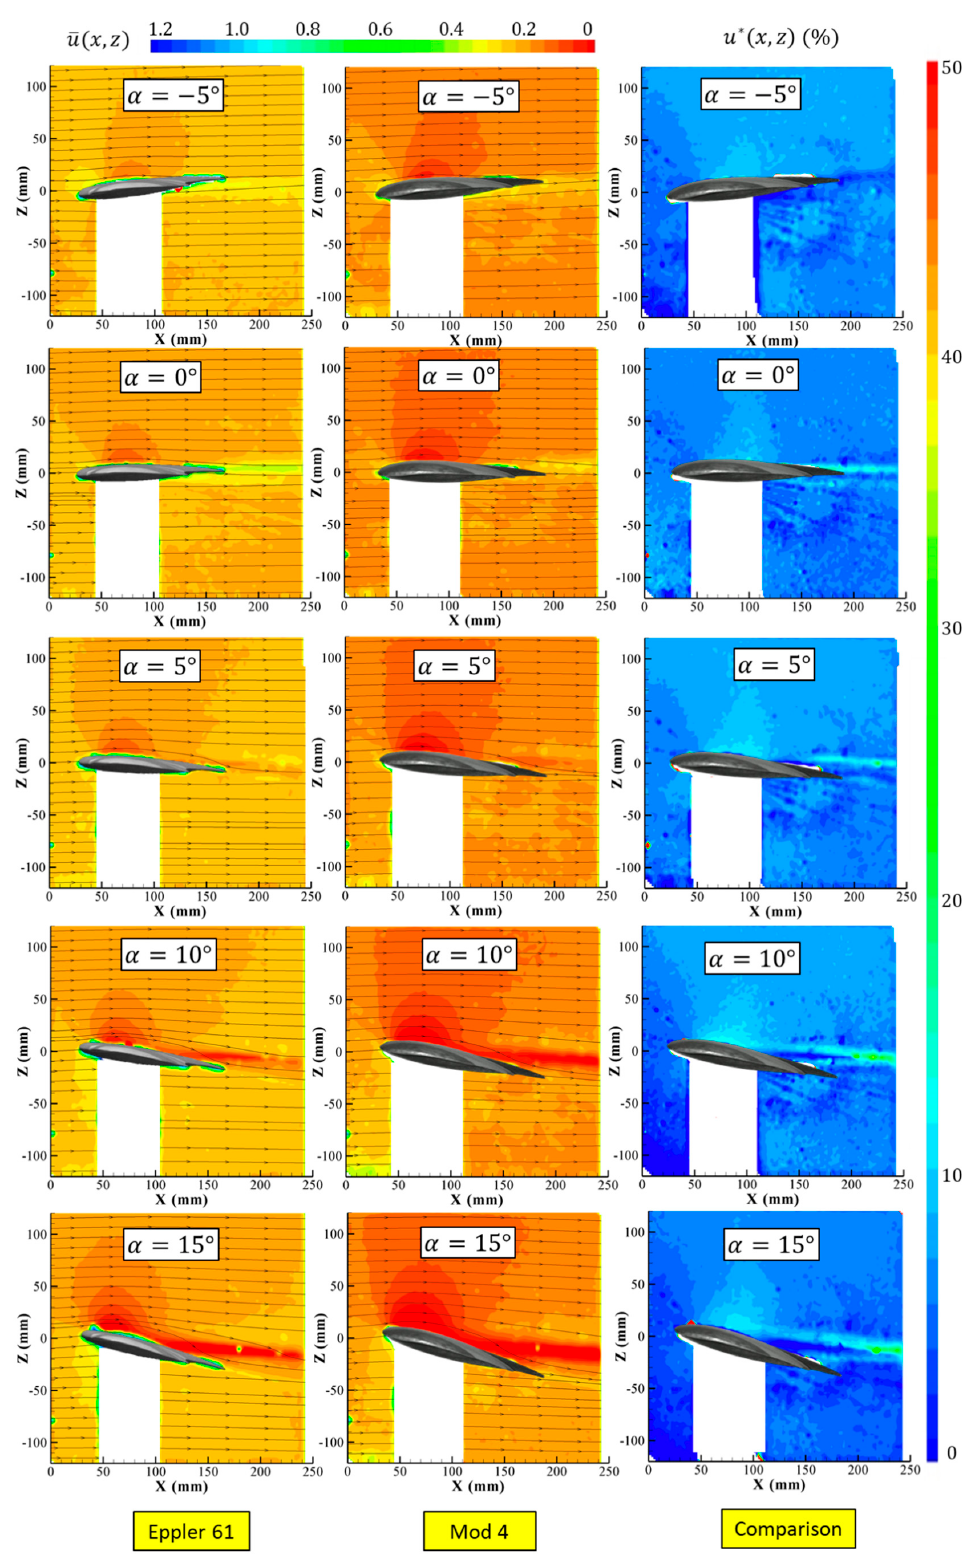
− 5 ◦ , 0 ◦ , 5 ◦ , 10 ◦ , and 15 ◦ 2 , for angles of attack